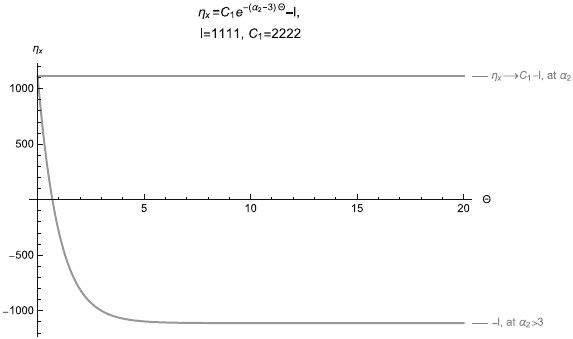
Fig. 22 Variation of η x with respect to (cid:16) for S when γ = 4